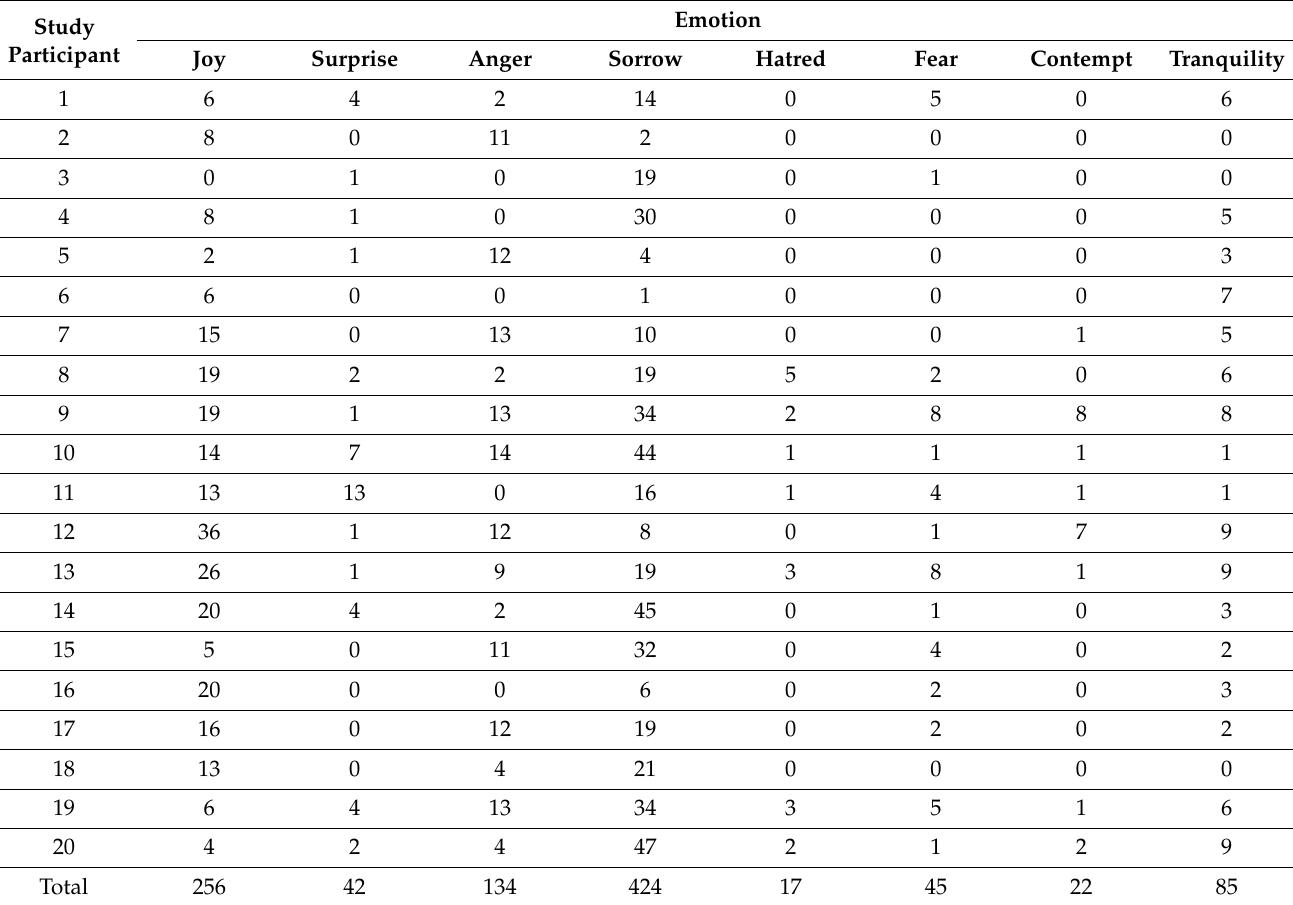
Table 4. Frequency of occurrence of emotions by survey